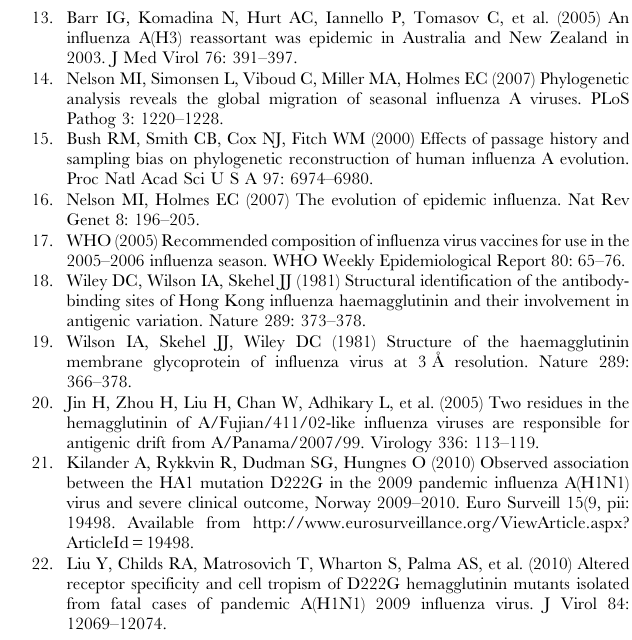
Table S1 Primers for whole genome sequencing of Influenza A(H3N2) viruses. Primers for gene fragment amplification and sequencing are highlighted in bold. Table S2 Relationship between phylogenetic clustering of viruses from fatal cases and main clinical findings (described with more detail in [ 8 ] ). Table S3 Set of A(H3N2) viruses selected from GenBank and used for the amino acid substitution comparison featured in Table 1. Text S1 FindSites analysis of the reassortant UK